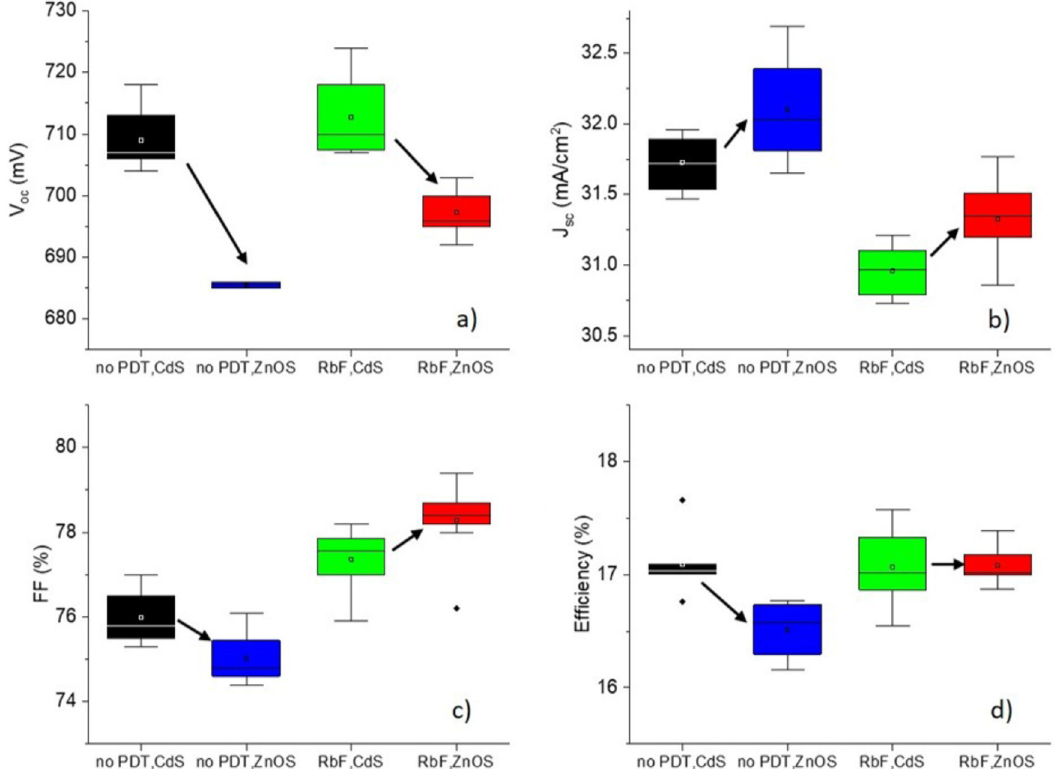
Fig. 2. V oc , J sc , FF and conversion ef fi ciency for the four different types of cells. The box plots include 8 – 10 cells of each type.